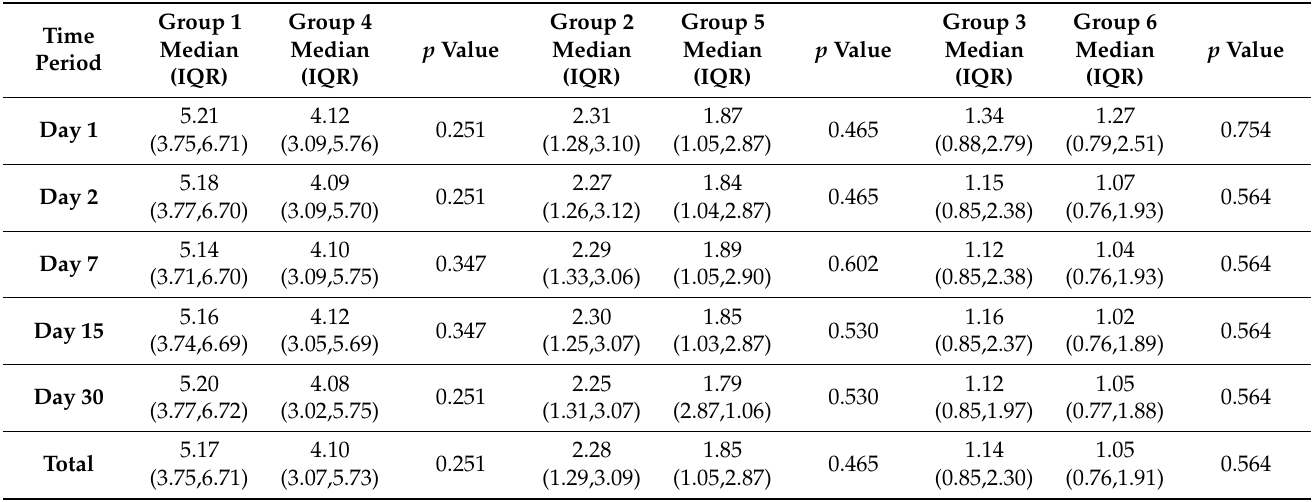
Table 1. Comparison baseline and baseline groups with fluoride release.